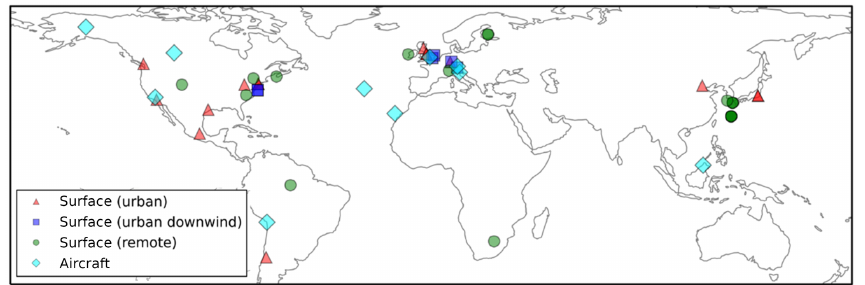
Figure 3. Global map showing the 40 surface AMS observations, originally compiled by Zhang et al. (2007), classified as urban (red triangles), urban downwind (blue squares), or remote (green circles). Of the surface observations, 37 have been classified as hydrocarbon- like OA and OOA. Observations from 10 aircraft campaigns, originally compiled by Heald et al. (2011), are also shown (light blue diamonds); these remain as total